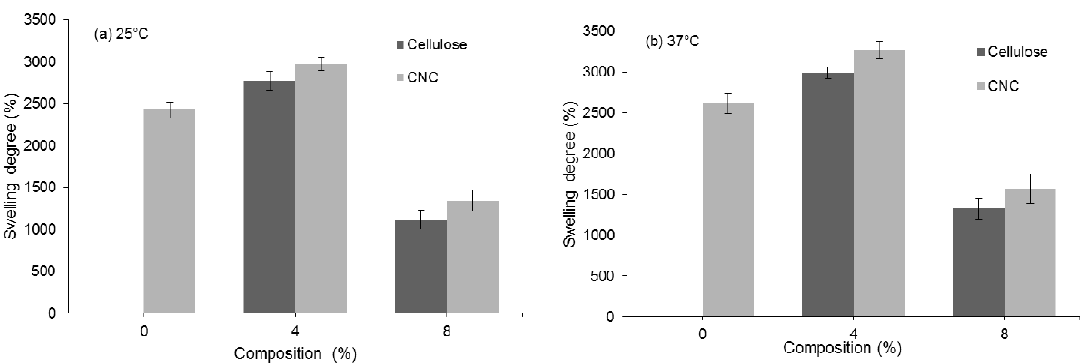
Figure 7. Swelling degree of PAA/cellulose and PAA/CNC hydrogels after 24 h incubation at ( a ) 25 °C and ( b ) 37 °C.